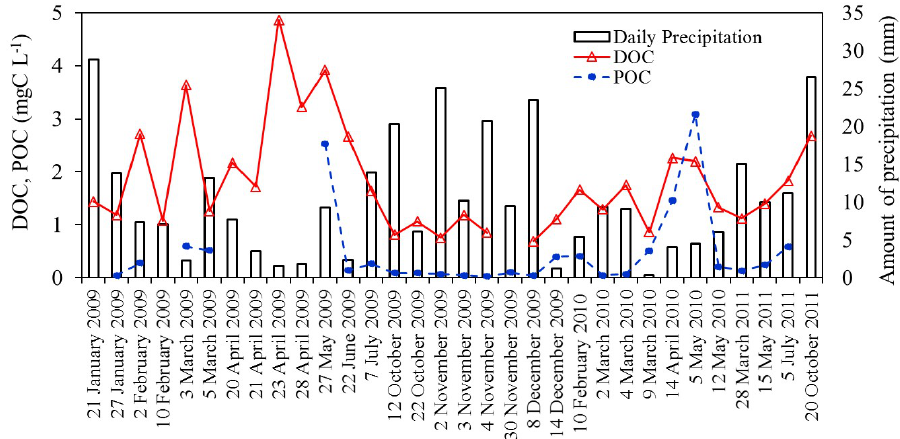
Figure 3. Temporal variability of dissolved organic carbon (DOC), particulate forms of organic carbon (POC) concentrations in rainwater in Zagreb, and daily amount of precipitation during the sampling period (2009–2011).